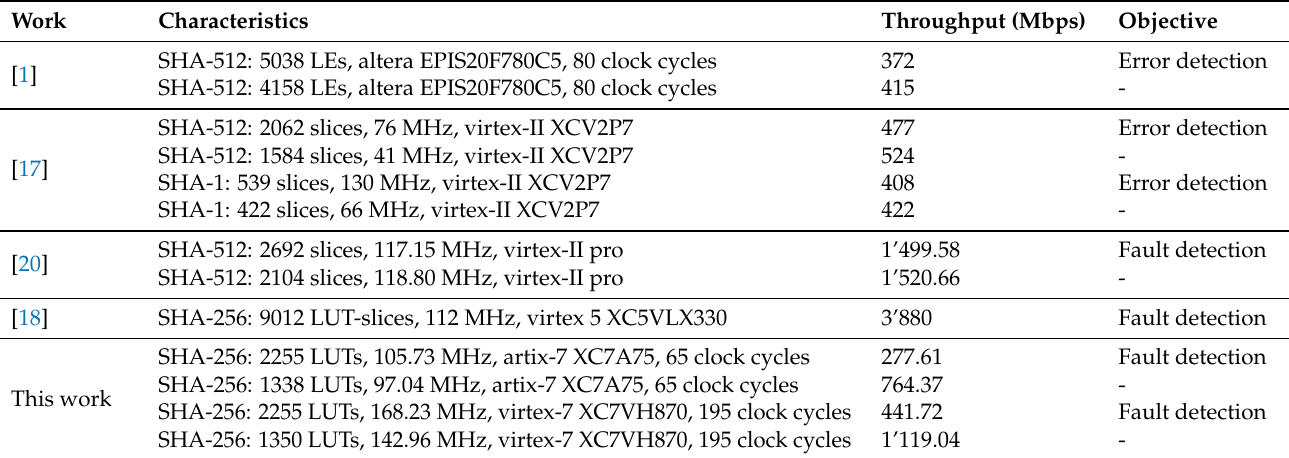
Table 5. Comparisons of hardware architectures between this and related